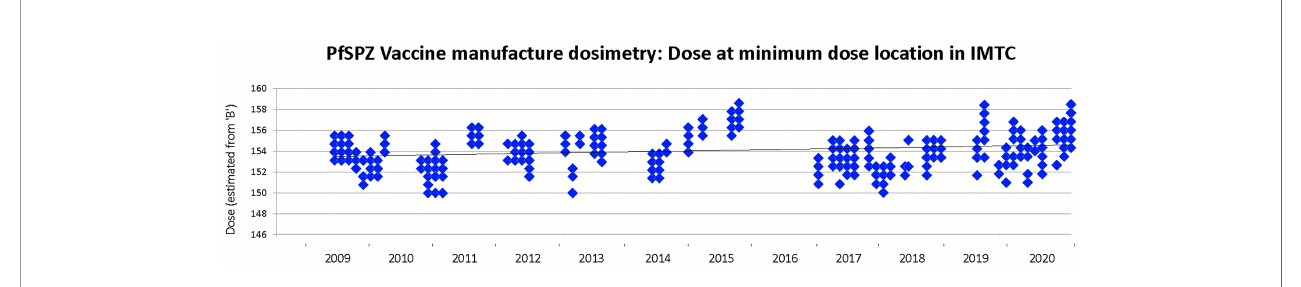
FIGURE 6 | Minimum dose of irradiation received by any mosquito during PfSPZ Vaccine production campaigns between 2009-2020. The target minimum dose is 150 Gy and the minimum acceptable dose is 142.5 Gy. Not all production campaigns were converted into lots released for clinical use, and none of the clinical released lots included PfSPZ irradiated below